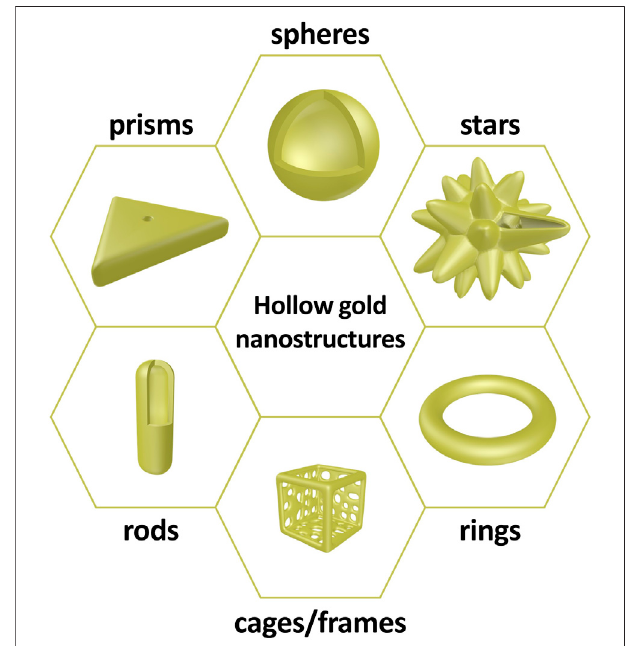
FIGURE 2 | Schematic illustrations of hollow gold nanostructures: spheres, stars, rings, cages/frames, rods, and